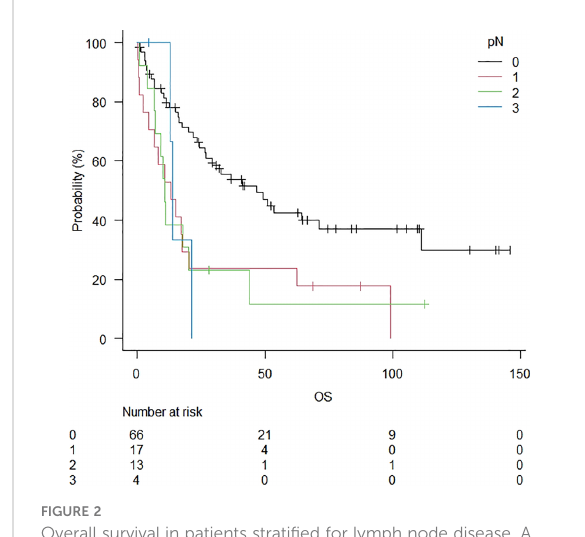
FIGURE 2 Overall survival in patients strati fi ed for lymph node disease. A signi fi cantly lower 5-year OS was observed in patients with the nodal disease (46.6% in pN0 vs 13.2% in pN+; p = 0.024).